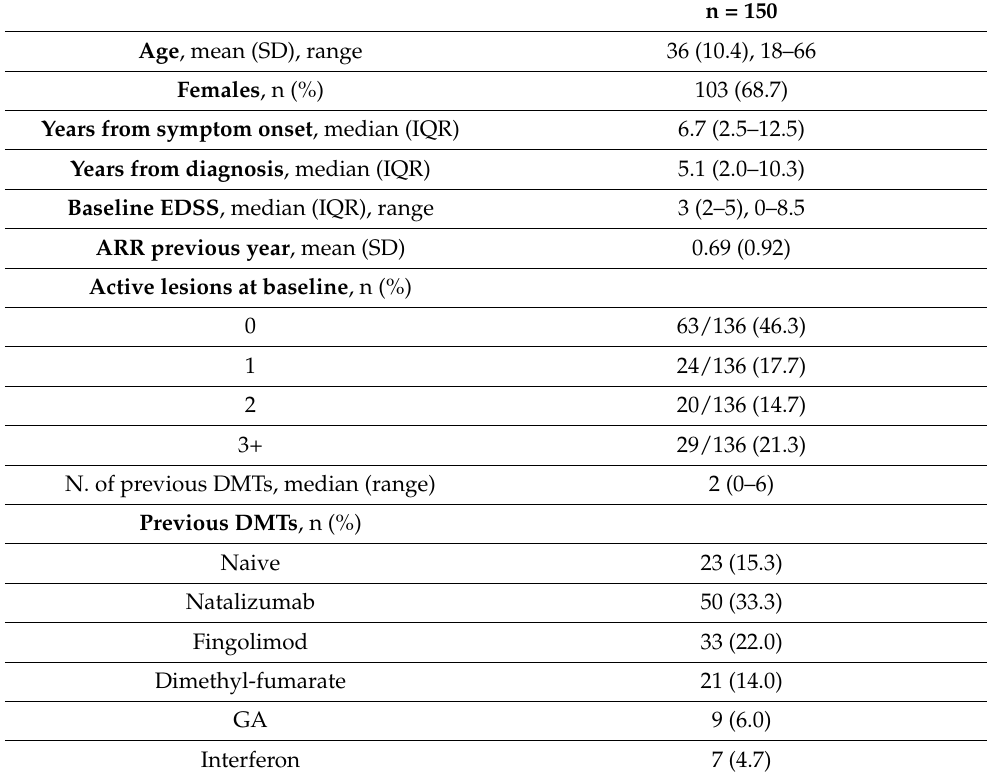
Table 1. Demographic and clinical characteristics of the included